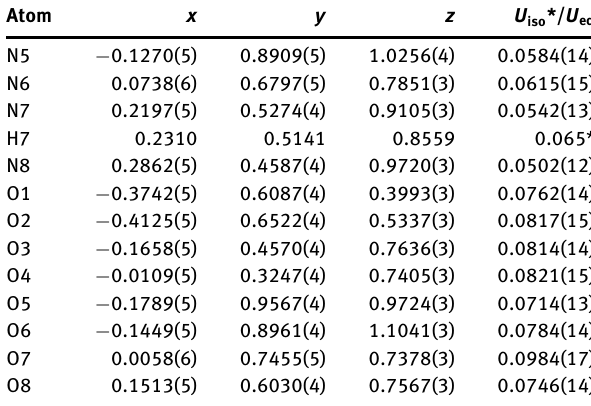
asymmetric unit. All bond lengths and angles are in nor- mal range. The two aromatic rings in each independent molecule are almost coplanar, with the dihedral angle of 4.99(2)° and 1.08(2)°, respectively. The C—N bond lengths in the independent molecules are 1.277(6) Å (C7—N4) and 1.299(6) Å (C21–N7), respectively, which are much shorter than the typical C = N bond length (1.34 Å– 1.38 Å). The C— N—N angles in each independent molecule of 116.4(5)° and 116.9(5)° are smaller than the ideal value of 120° expected for sp 2 -hybridized N